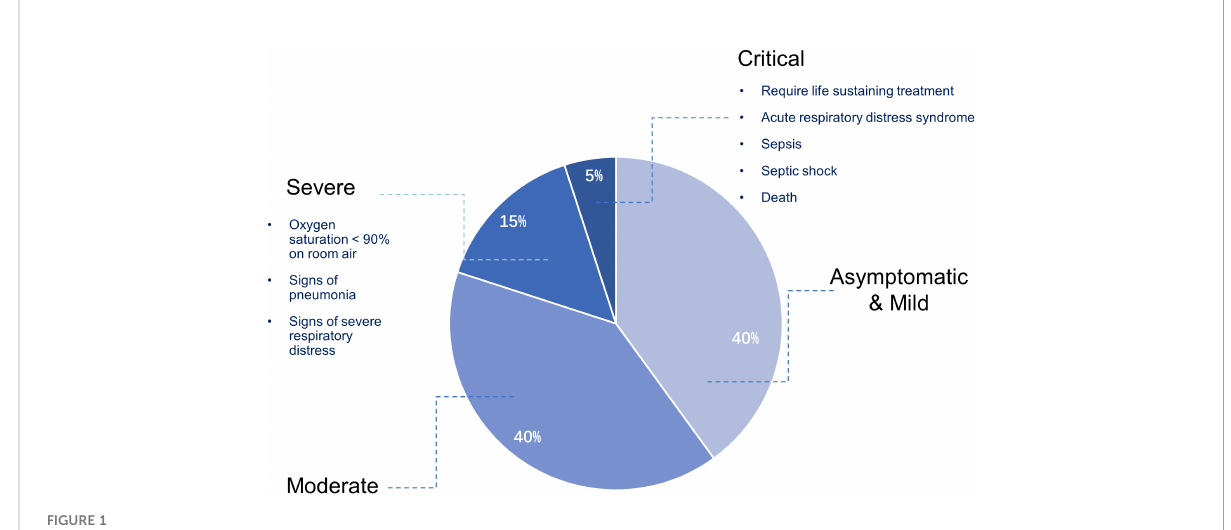
FIGURE 1 Overview of clinical characteristics of